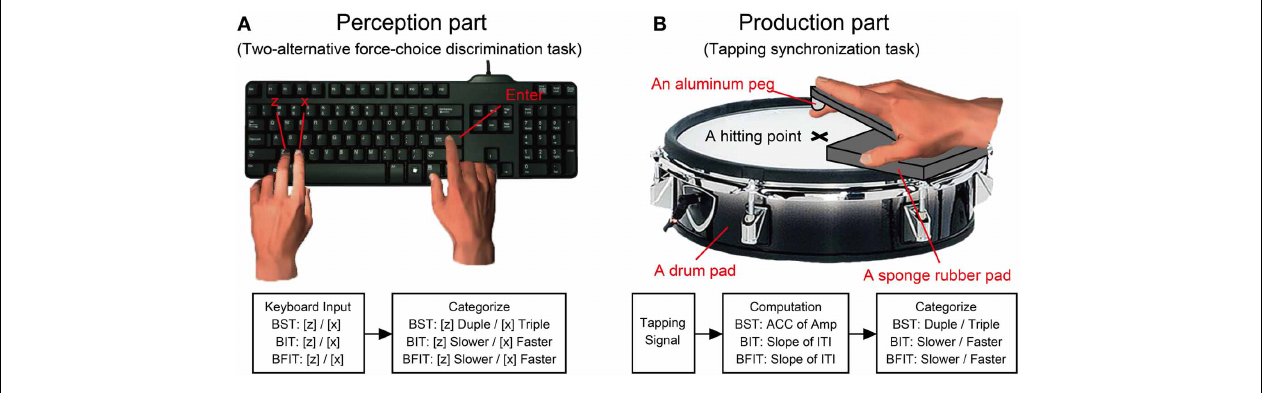
FIGURE 2 | A schematics of experimental apparatus and procedure. (A) Participants responded using a keyboard in the perception parts of Beat Saliency Test (BST), Beat Interval Test (BIT), and Beat Finding and Interval Test (BFIT). (B) In the production parts, participants tapped on a drum pad